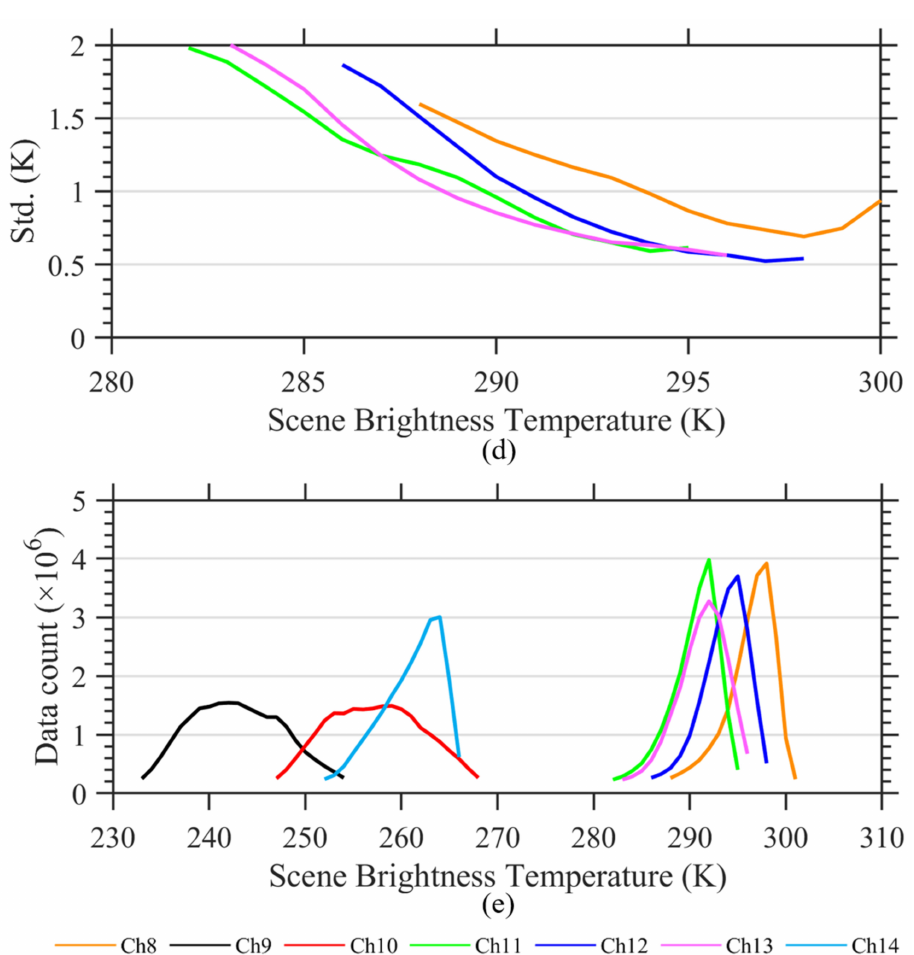
Figure 11. Variations of ( a , b ) biases and ( c , d ) standard deviations of OMBFNL, as well as ( e ) data counts with respect to scene brightness temperature for AGRI bands 8–14 over the ocean in January, April, July, and October